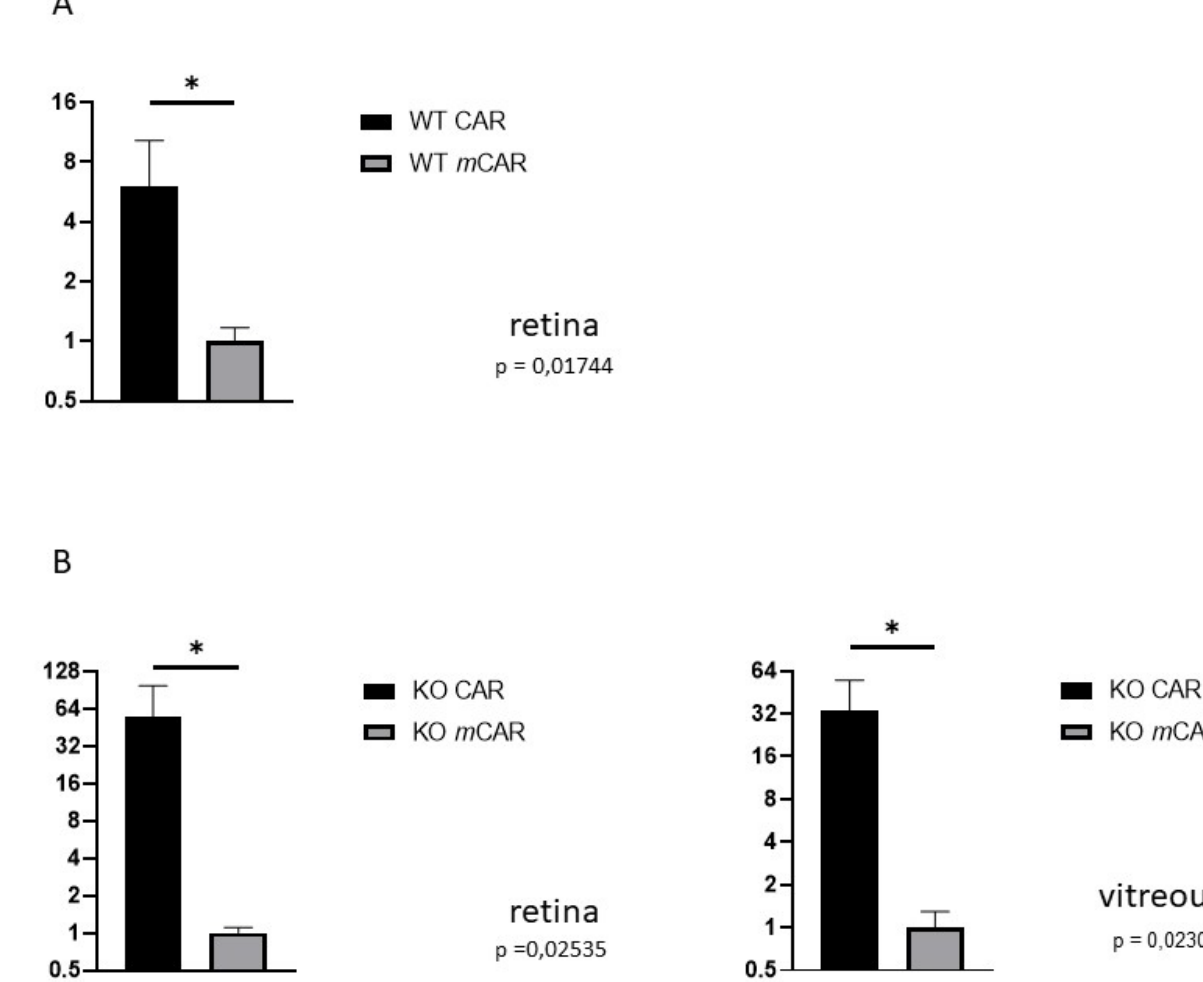
Figure 2. CAR peptide homes to the retina in retinopathy. The CAR and control peptide, m CAR, were administered intraperitoneally in normal ( A ) and R-Ras KO mice ( B ) in OIR. The homing of the peptide to the retina and vitreous was detected immunohistochemically and quantified with automated image analysis system. ( A ) CAR peptide homes to the retina 6.2-fold more than does the m CAR control peptide in OIR. ( B ) The angiogenic vasculature is hyperpermeable in R-Ras KO mice in OIR. The homing of the CAR peptide is increased by almost 60-fold more than the m CAR control peptide in OIR retina and also accumulates significantly more in the vitreous than m CAR in R-Ras KO mice (* p < 0.05).